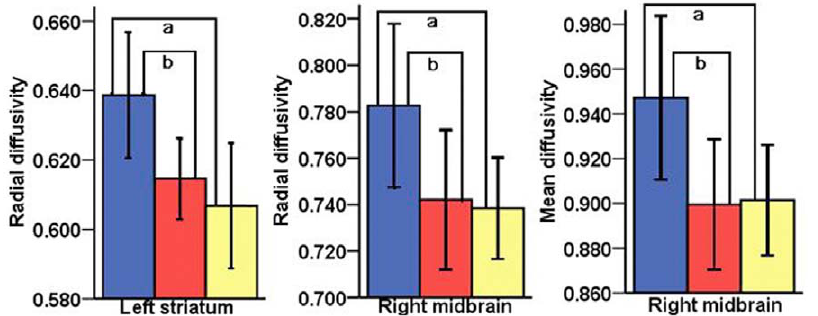
Figure 2. Regional radial diffusivity and mean diffusivity in follow-up patients before and after treatment and healthy controls. Blue bar represents follow-up patients at baseline (N=15), red bar represents follow-up patients after treatment (N=15), yellow bar represents healthy controls (N=23). Error bars is 95% CI (confidence intervals). The units of radial diffusivity (RD) and mean diffusivity (MD) is 10 2 3 mm 2 /s. a Significant difference between obsessive-compulsive disorder patients and healthy controls (p , 0.001, ANOVA with least significant difference post hoc test).